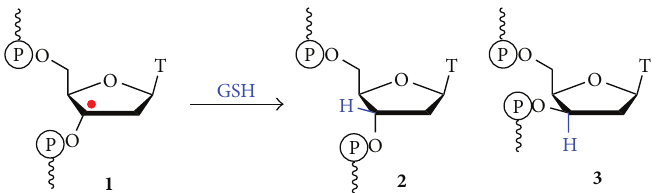
Figure 2: Reduction of the C3 󸀠 -thymidinyl radical by GSH. Formation of substrates containing the repaired 2 󸀠 -deoxyribose ( 2 ) and the 1-(2 󸀠 -deoxy- 𝛽 -D- threo -pentofuranosyl)thymidine ( 3 ) damage lesion were observed